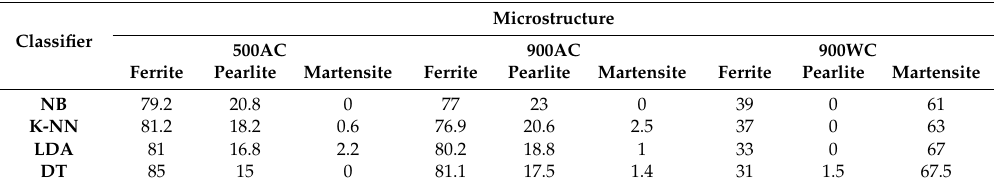
Table 10. Volume fractions (%) of distinct metallurgical phases.